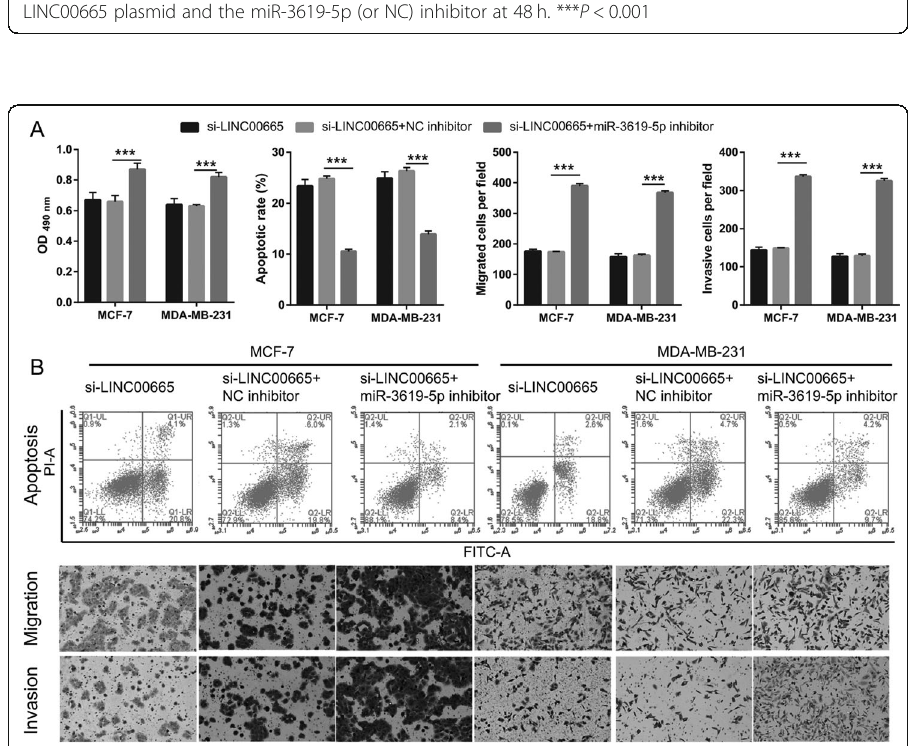
Fig. 7 Simultaneous knockdown of LINC00665 and miR-3619-5p promoted breast cancer (BC) cell proliferation, migration, and invasion, but inhibited apoptosis. a Proliferation, apoptosis, migration, and invasion, as measured by performing 3-(4,5-dimethylthiazol-2-yl)-2,5-diphenyltetrazolium bromide (MTT) assays, flow cytometry, transwell migration assays, and invasion assays, respectively. The data shown are the mean ± standard deviation (SD). b Representative images showing BC cell apoptosis, migration, and invasion. *** P <